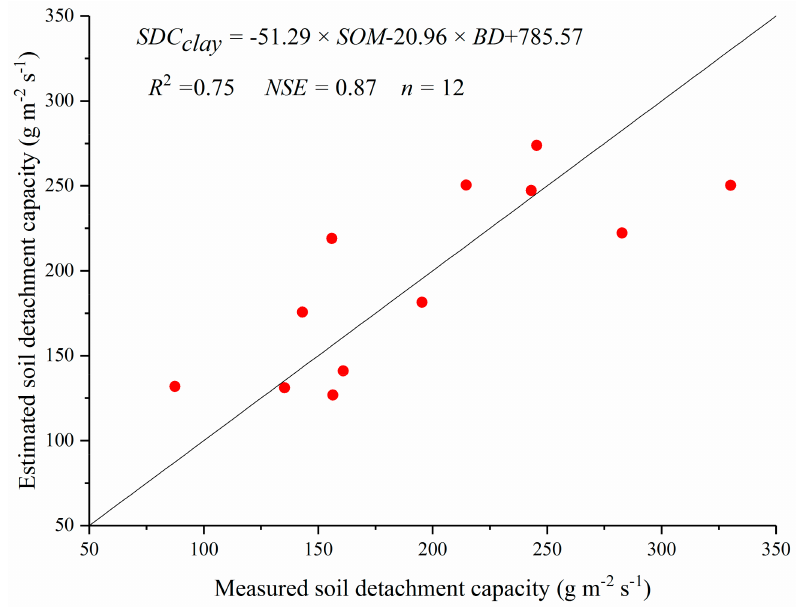
Figure 11. Measured soil detachment capacity vs. estimated ones using Equation (3) of clay